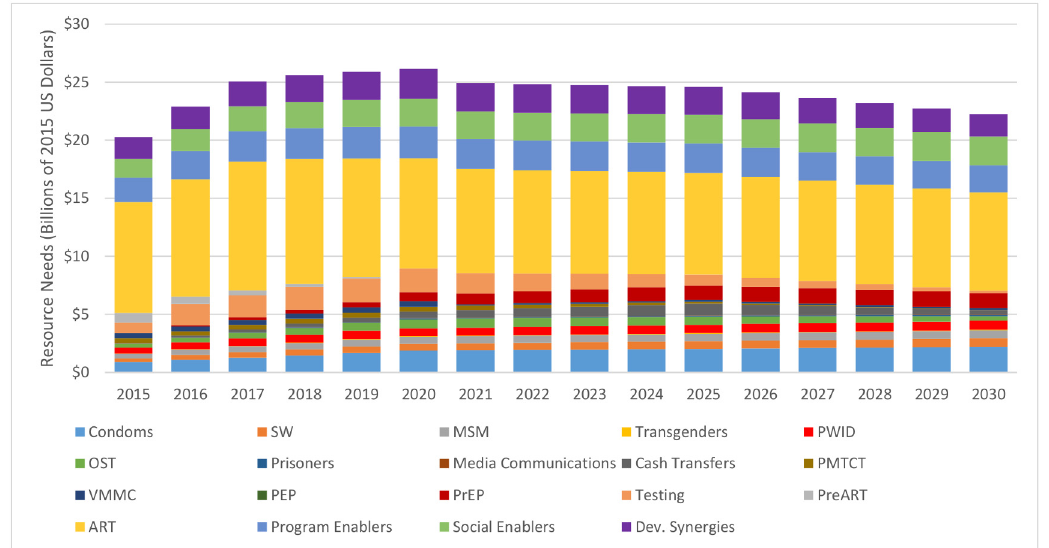
Fig 2. Annual Resource Needs by Intervention, 2013 – 2030. Key: SW = sex workers, MSM = men who have sex with men, PWID = people who inject drugs, OST = opioid substitution therapy, PMTCT = prevention of mother-to-child transmission, VMMC = voluntary medical male circumcision, PEP = post-exposure prophylaxis, PrEP = pre-exposure prophylaxis, Dev. Synergies = Development